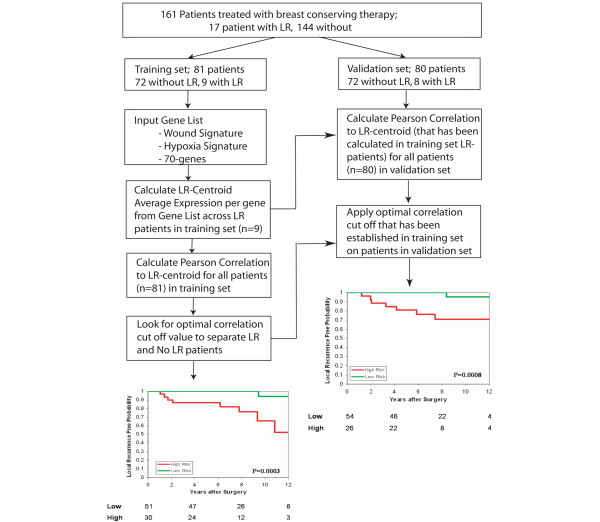
Scheme for training and validation, including Kaplan–Meier curves for local-recurrence-free survival.